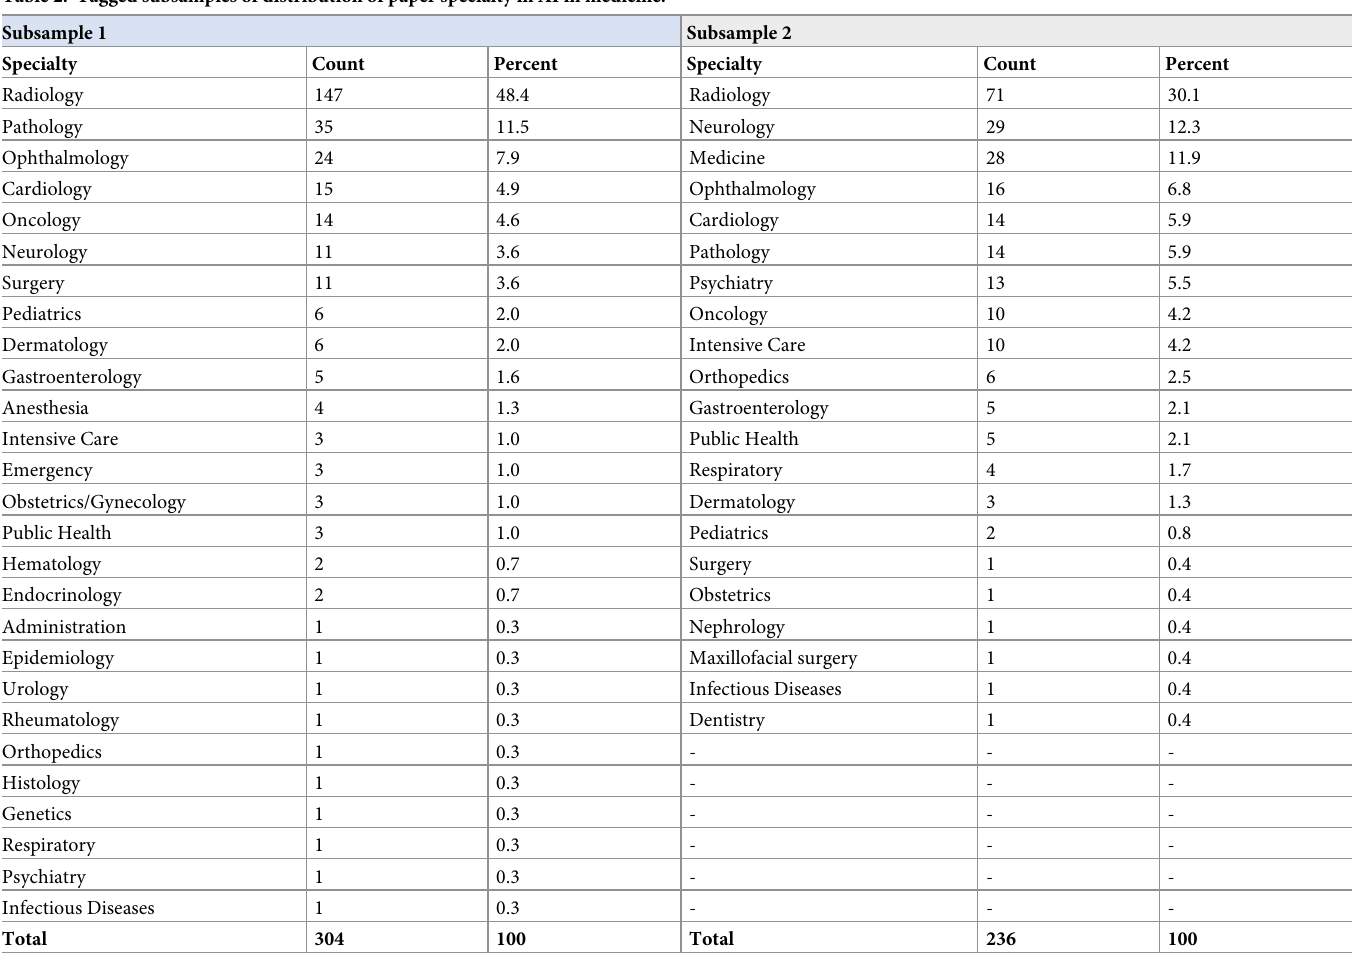
Table 2. Tagged subsamples of distribution of paper specialty in AI in